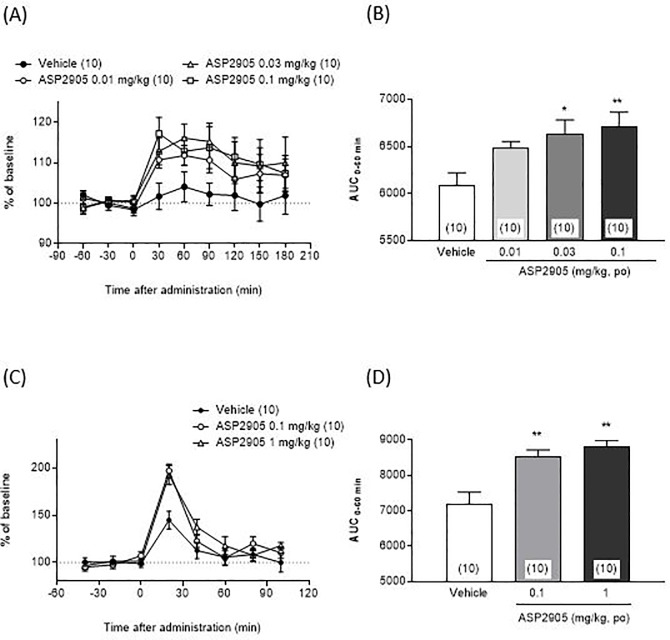
Effects of ASP2905 on the extracellular levels of DA (A, B) and ACh (C, D) in the rat mPFC. Data are expressed as the mean ± SEM of percentages of the baseline (A and C) and AUCs 60 min after administration of ASP2905 (B and D). The numbers in parentheses indicate the number of rats in each group. For DA, animals with basal levels differing by ± 10% from the mean were excluded from the analysis. The IPHC values for ACh were compensated by the IPHC value of the third point acquired before administering ASP2905, and the value of ACh was corrected using the compensated value of IPHC. When the basal level differed by >30% from the mean, the data for that animal were excluded from the analysis. *p<0.05, **p<0.01 vs vehicle-treated group (Dunnett’s test). A) Extracellular levels of DA after administration of ASP2905. B) AUCs of the levels of DA in the mPFC 60 min after administration of ASP2905. C) Extracellular ACh levels after administration of ASP2905. D) AUCs of the levels of Ach in the mPFC 60 min after administration of ASP2905.